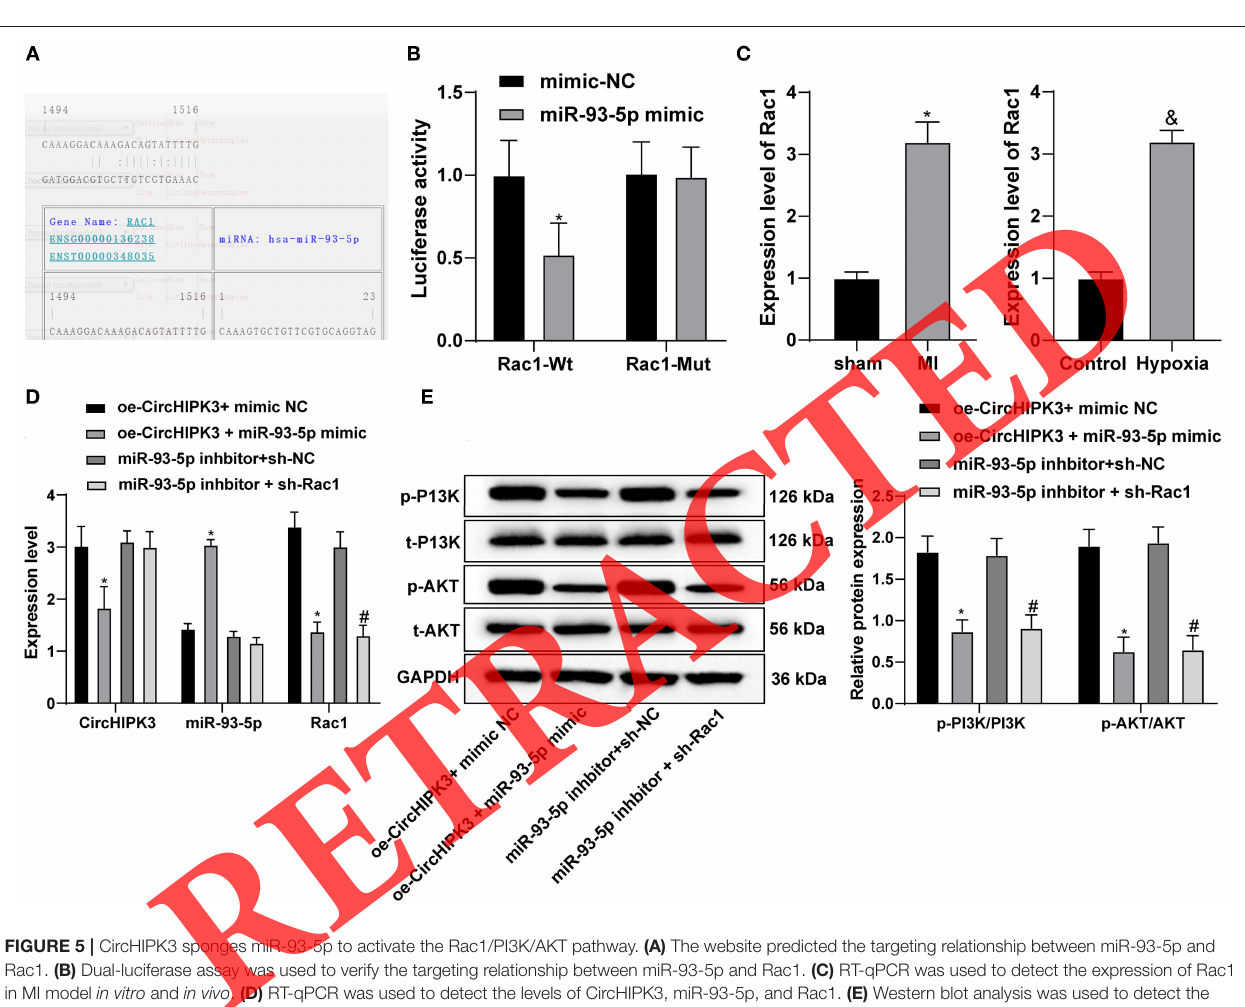
FIGURE 4 | CircHIPK3. (C) 2,3,5-Triphenyltetrazolium chloride staining was used to detect infarct size. (D) Masson staining was used to detect collagen deposition. (E) TUNEL staining was used to observe the apoptosis of myocardial tissue, n = 10. (F) RT-qPCR detected miR-93-5p expression in cardiomyocytes in vitro . (G) The apoptosis of cardiomyocytes was detected by TUNEL staining. (H) Western blot analysis detected the expression of Bax, cleaved caspase-3, and Bcl-2 protein. The value in the figures is the measurement data, which is expressed as mean ± standard deviation. The comparison between two groups was analyzed by independent-sample t -test. The correlation of circHIPK3 and miR-93-5p was analyzed using Pearson’s correlation analysis. The comparison among multiple groups was analyzed by one-way ANOVA, followed by Tukey’s multiple-comparisons test. *compared with oe-NC + agomiR-NC group, p < 0.05; # compared with